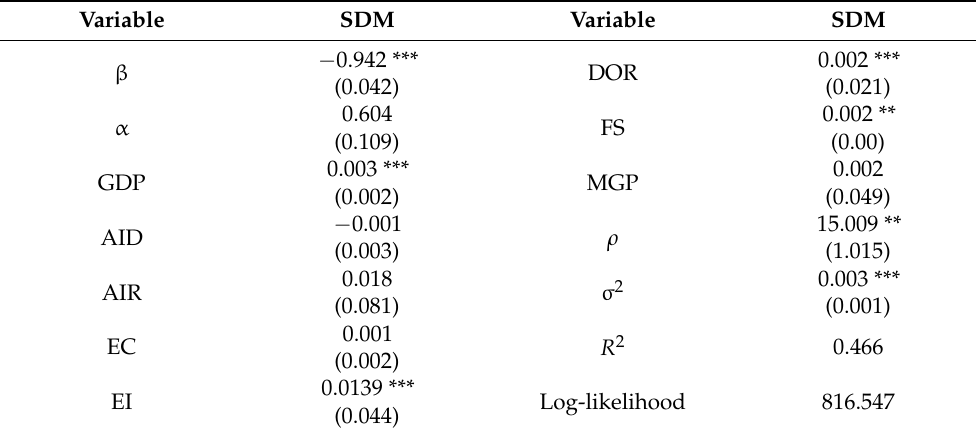
Table 8. Results of the conditional β convergence test for the dynamic spatial SDM of AGTFP.